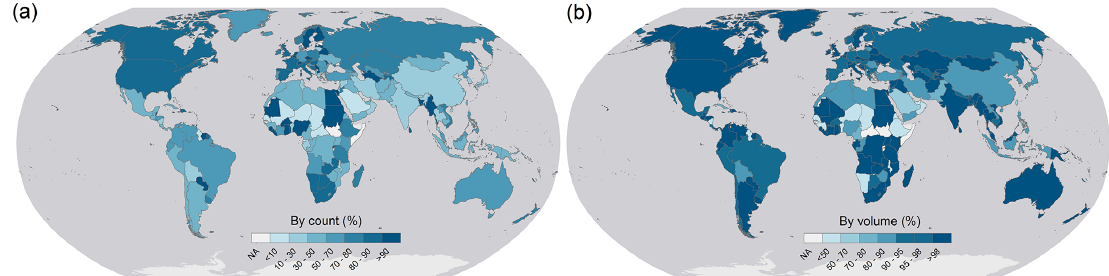
Figure 10. GeoDAR (v1.1) as a proportion of the ICOLD WRD for each country or territory. (a) By dam count and (b) by reservoir storage capacity. Statistics for Taiwan and Greenland were computed separately from mainland China and Denmark (the same for Figs. 14 and S1 in the